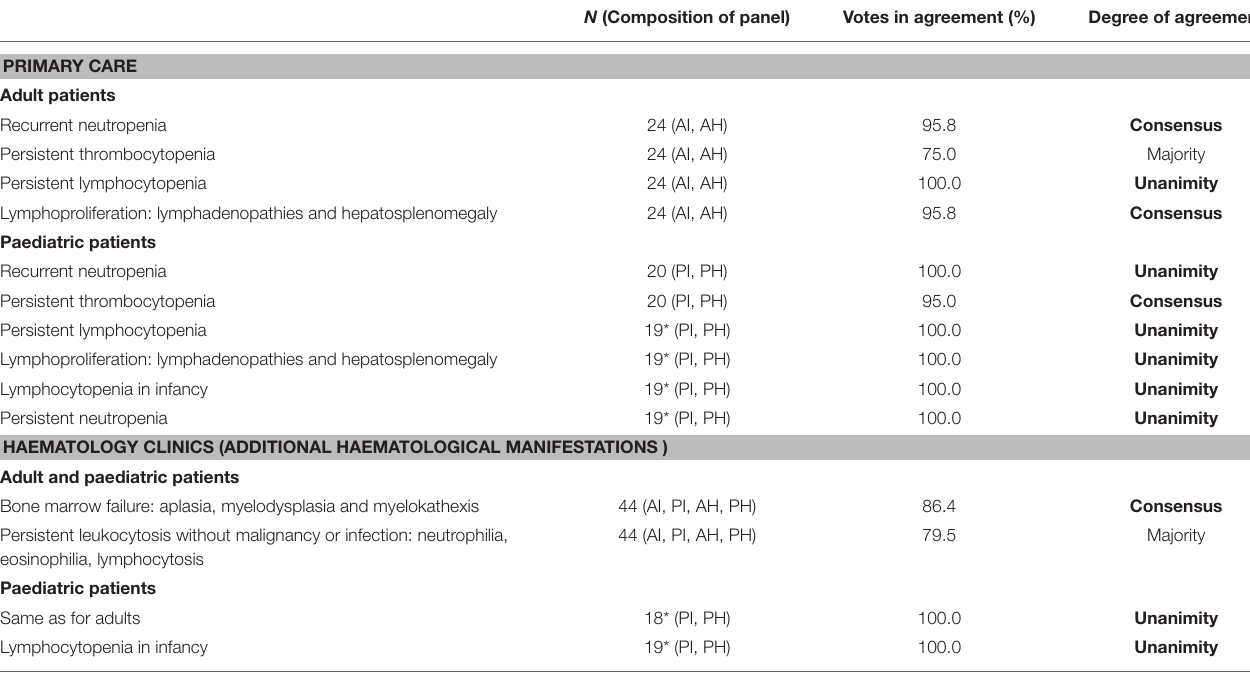
TABLE 1 | Haematological manifestations that should prompt a suspicion of PID in primary care and haematology consultations.